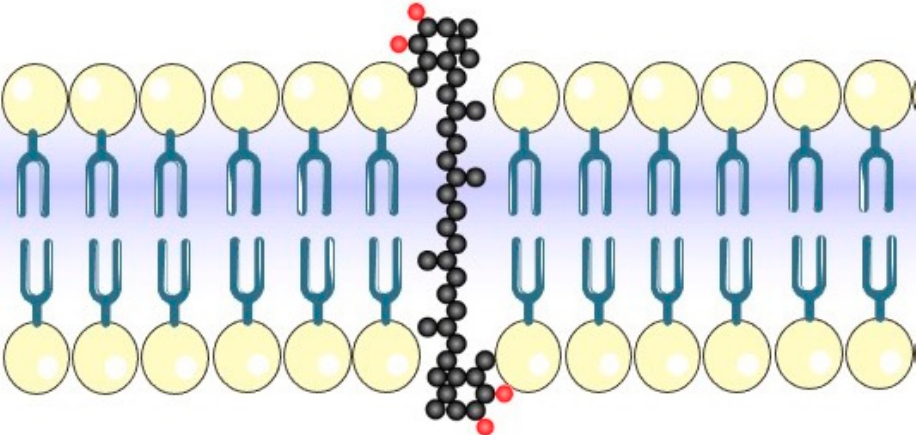
Figure 2. Astaxanthin cell-membrane insertion. Carbon (black circles). Oxygen (red circles). Polar region of bilayer phospholipid membrane (yellow circles). (Illustrations provided by Servier Medical Art, licensed under the Creative Commons Attribution 3.0 unported license (https://smart.servier.com accessed in 19 May 2021)).